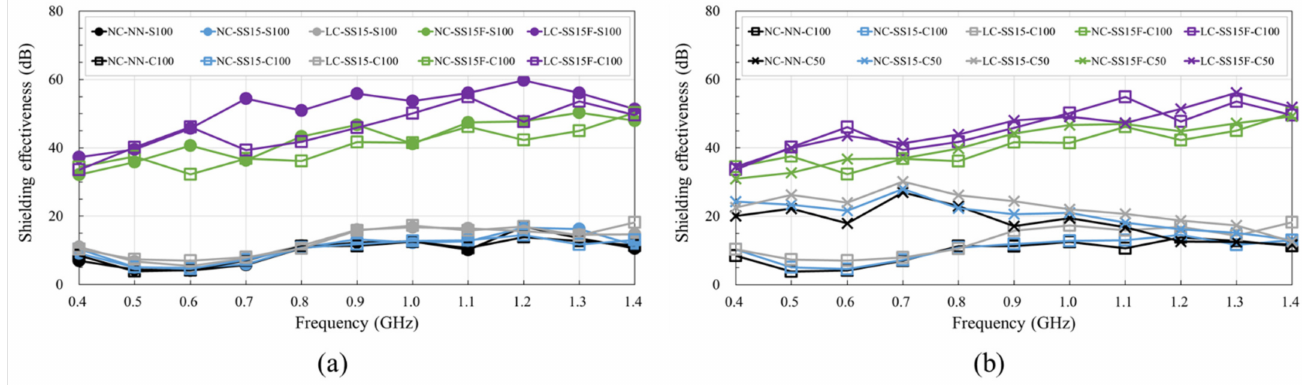
Figure 10. Comparison of shielding effectiveness of concrete for different reinforcement types and spacings: ( a ) type (steel vs. CFRP); ( b ) spacing (100 vs. 50